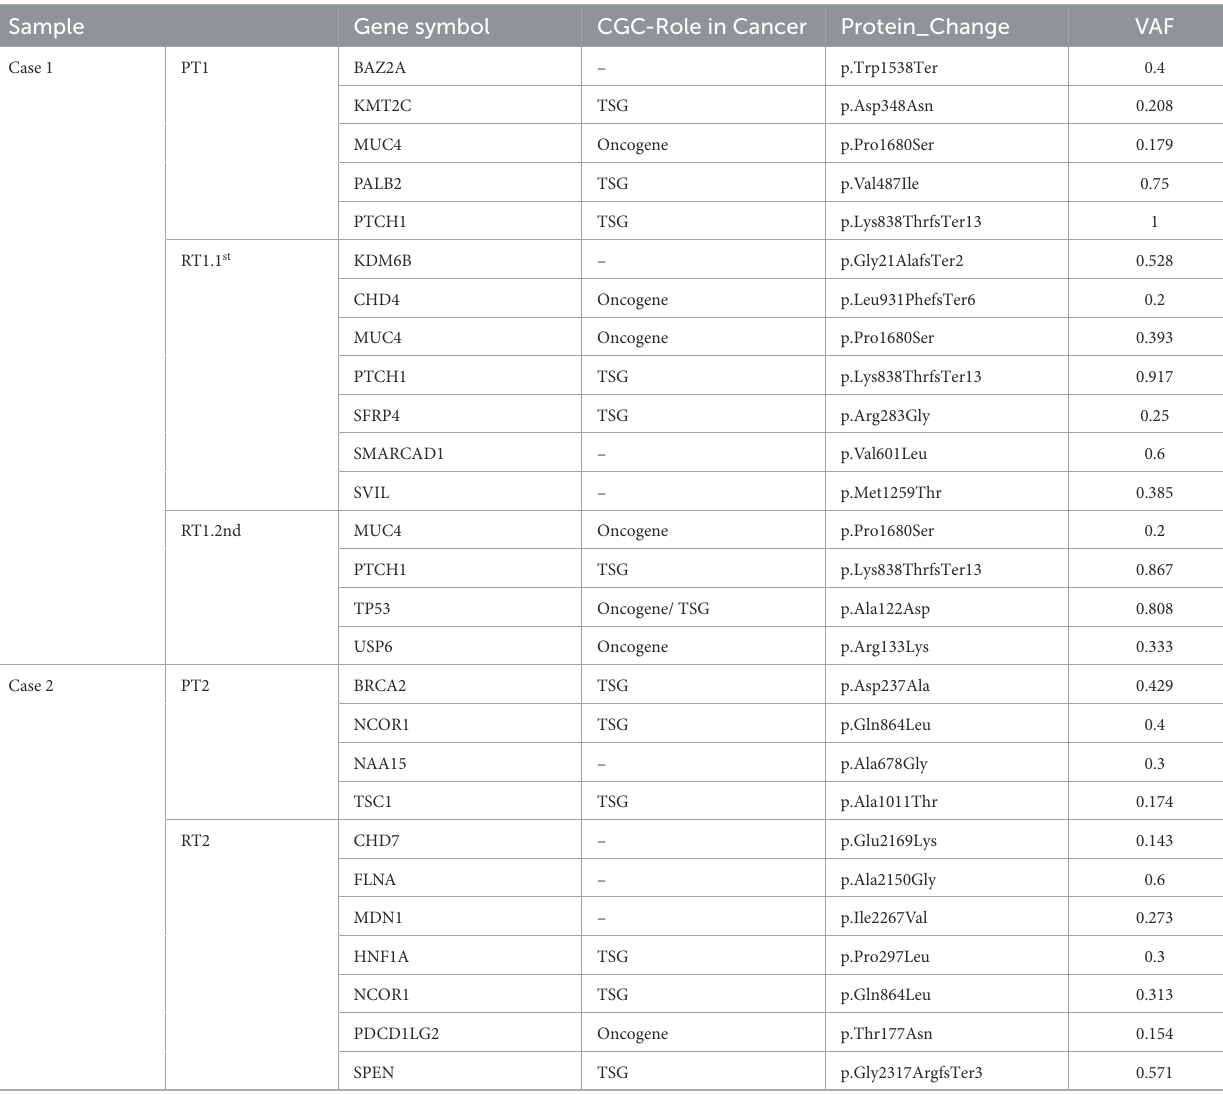
TABLE 1 Potential driver mutations of primary MBs and paired sub-frontal